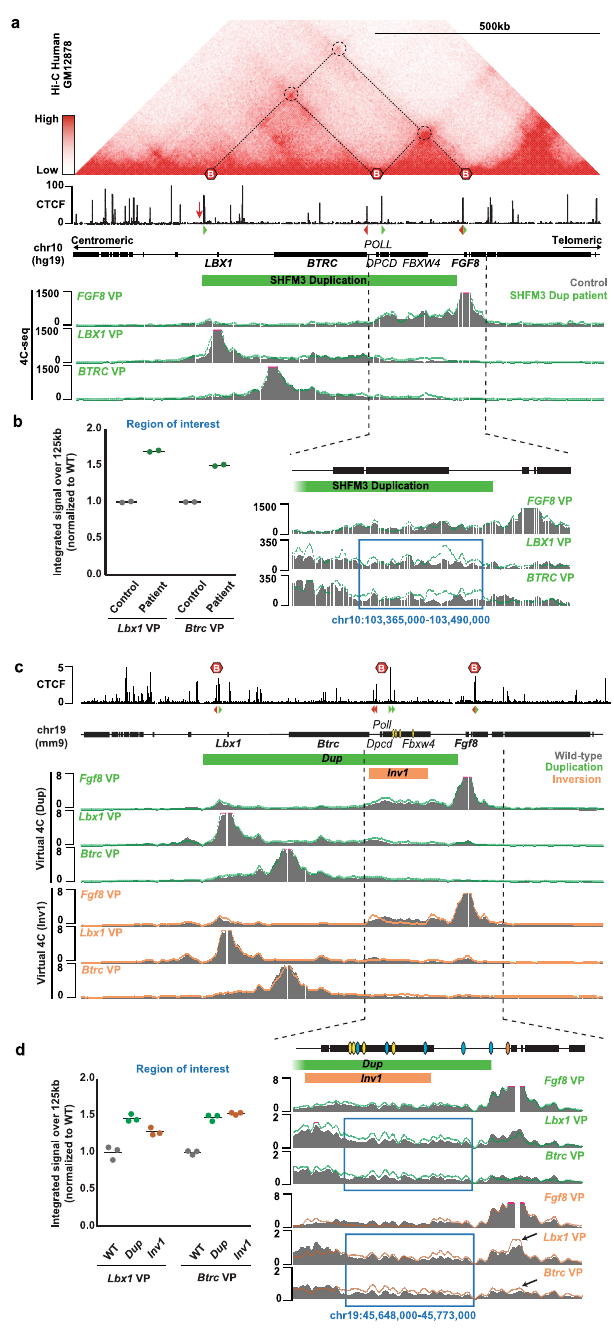
Fig. 3 | 4C-seq in SHFM3 patient fi broblasts reveals ectopic interactions involving LBX1 and BTRC , further supported by virtual 4C in mouse. a Hi-C at the LBX1 / FGF8 locus(hg19;chr10:102,668,128-103,840,922)derivedfromGM12878 cell 50 .TADsstructuresaresimilarbetweenhumanandmouse.CTCFChIP-seqfrom GM12878 cells 62,63 , orientation of CTCF binding sites and schematic of the human LBX1/FGF8 locus are shown below. Red arrow indicates a CTCF binding site in antisense orientationatthe LBX1 centromericTAD boundarypresentinmousebut notinhuman.Belowisthenormalized4C-seqofhuman fi broblastshealthycontrol (grey)versusaSHFM3patientcarryingtheduplication(greenline)withviewpoints (VP) on FGF8 , LBX1 and BTRC promoters. Data are shown as merged signal of n =2 replicates. b (Left panel) 4C-seq integrated signal over a 125kb region comprising the FGF8 regulatory elements that are duplicated. (Right panel) A zoom-in view fromthe4C-seqshowingtheregionusedfortheintegratedsignal(bluerectangle). We observed an increase of contacts between both LBX1 and BTRC promoters and the FGF8 regulatory elements which is not present in control regions (Supple- mentary Fig. 4). c Similar representation as in ( a ) showing the mouse CTCF and virtual 4C (generated from E11.5 limbs cHi-C maps from Fig. 2) tracks. Wild-type (WT) signal is shown in grey and Dup and Inv1 with a green and orange line, respectively. Data are shown as merged signal of n =3 replicates. d (Left panel) Virtual-4C integrated signal over the 125kb region comprising Fgf8 regulatory elements that are affected by the duplication and the inversion. (Right panel) A zoom-in view from the virtual-4Cshowing the 125kb used for the integratedsignal (blue rectangles). Black arrow highlights a gain of contact observed only for Lbx1 viewpointwiththe Fgf8 gene,outsideoftheregionofinterest.Gainofinteractions is observed between both Lbx1 and Btrc promoters and the Fgf8 regulatory ele- ments which is not present in control regions (Supplementary Fig.